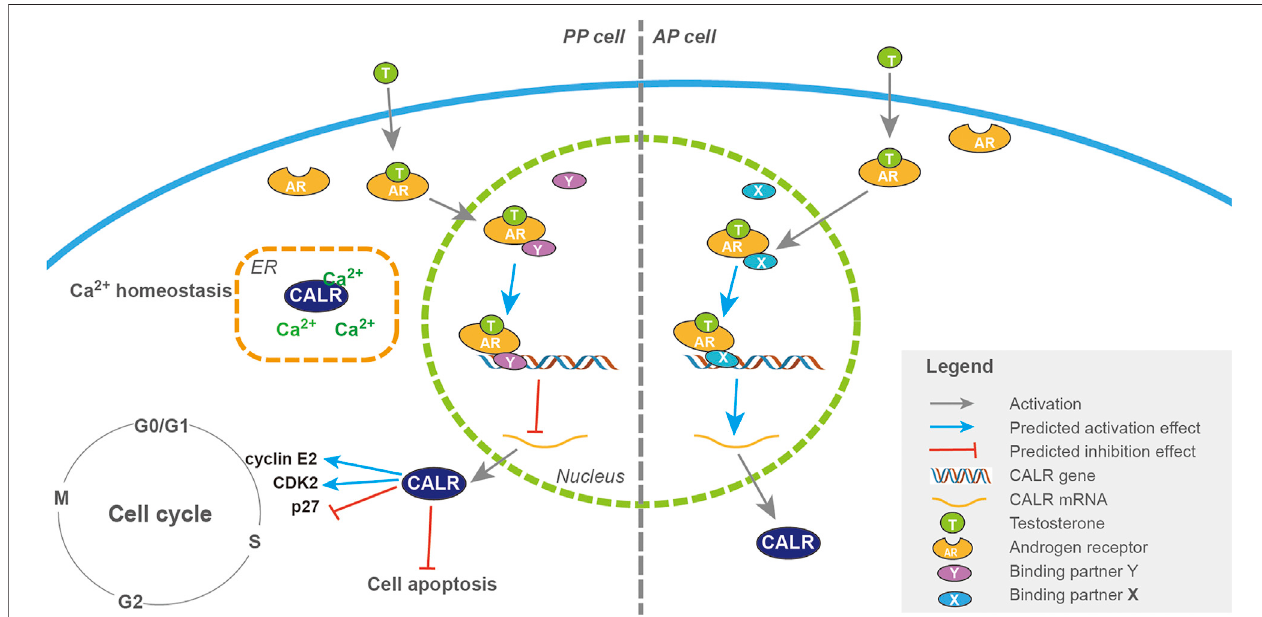
FIGURE 11 | Pathways of CALR regulation by androgens in the activation of PP and AP cells during antler regeneration and pedicle formation, respectively. SchematicdrawingoftheregulatorypathwaysofCALRexpressionbyandrogenduringinitiationofantlerregeneration(PP;lefthalf)andpedicleformation(AP;righthalf). TbindstotheARonceithasenteredthecytoplasm,andthecomplexofAR+Tinteractswithaputativebindingpartneroncetranslocatedintothenucleus,andthetriad (AR+T+partner)servesasatranscriptionalfactoreitherdownregulating(withpartnerYinthePP,refertothelefthalf)orupregulating(withpartnerXintheAP,refer to the right half) the expression of the CALR gene. A high level of CALR expression stimulates cell proliferation through facilitation of cell cycle progression (P27, CDK2, and cyclin E2).